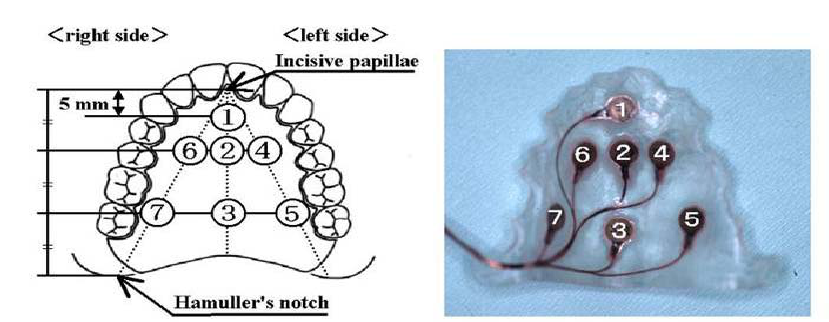
Figure 8. Location of pressure sensors (left) and an artificial palate (right). Each sensor is located with reference to the anatomical landmarks of the maxilla, such as the incisive papillae and Hamuller’s notch [47].